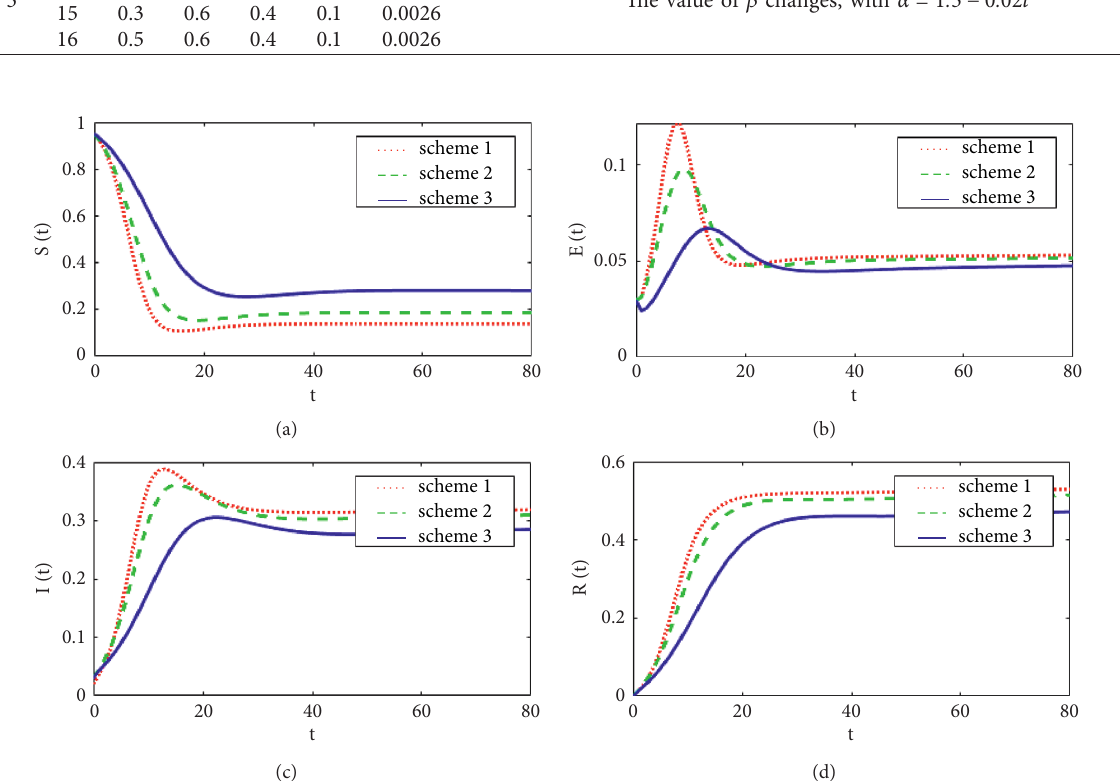
Figure 2: The curves of changes in the population density of netizens in the four categories at different contact rates of α